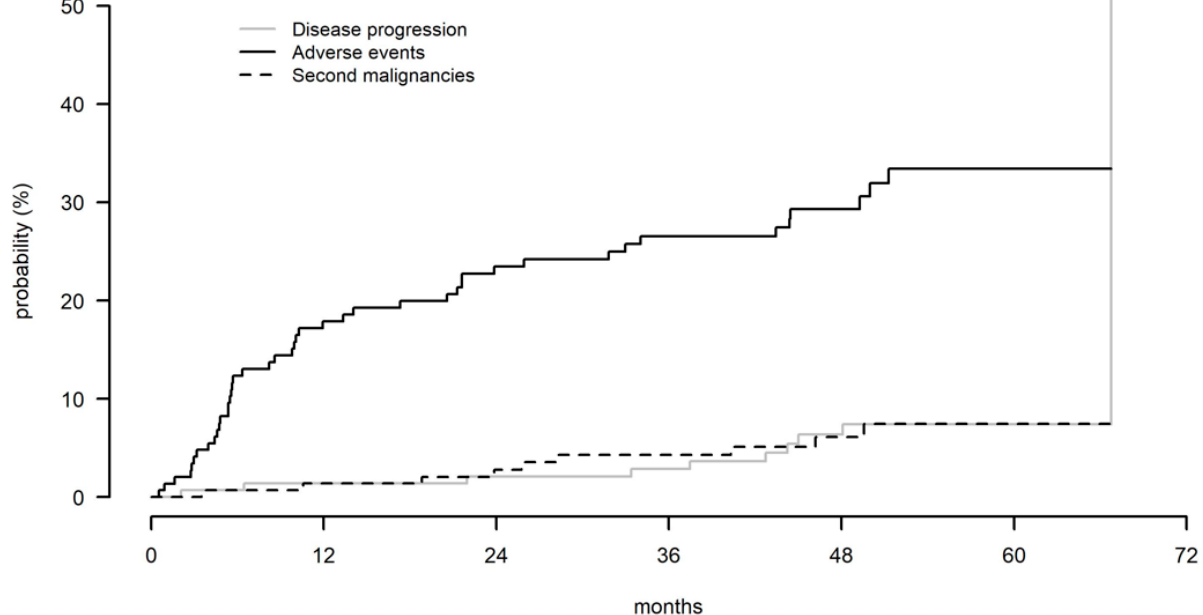
Figure 2. Cumulative rates of treatment discontinuation according to the reasons for treatment discontinuations, disease progression, adverse events, and second malignancies.